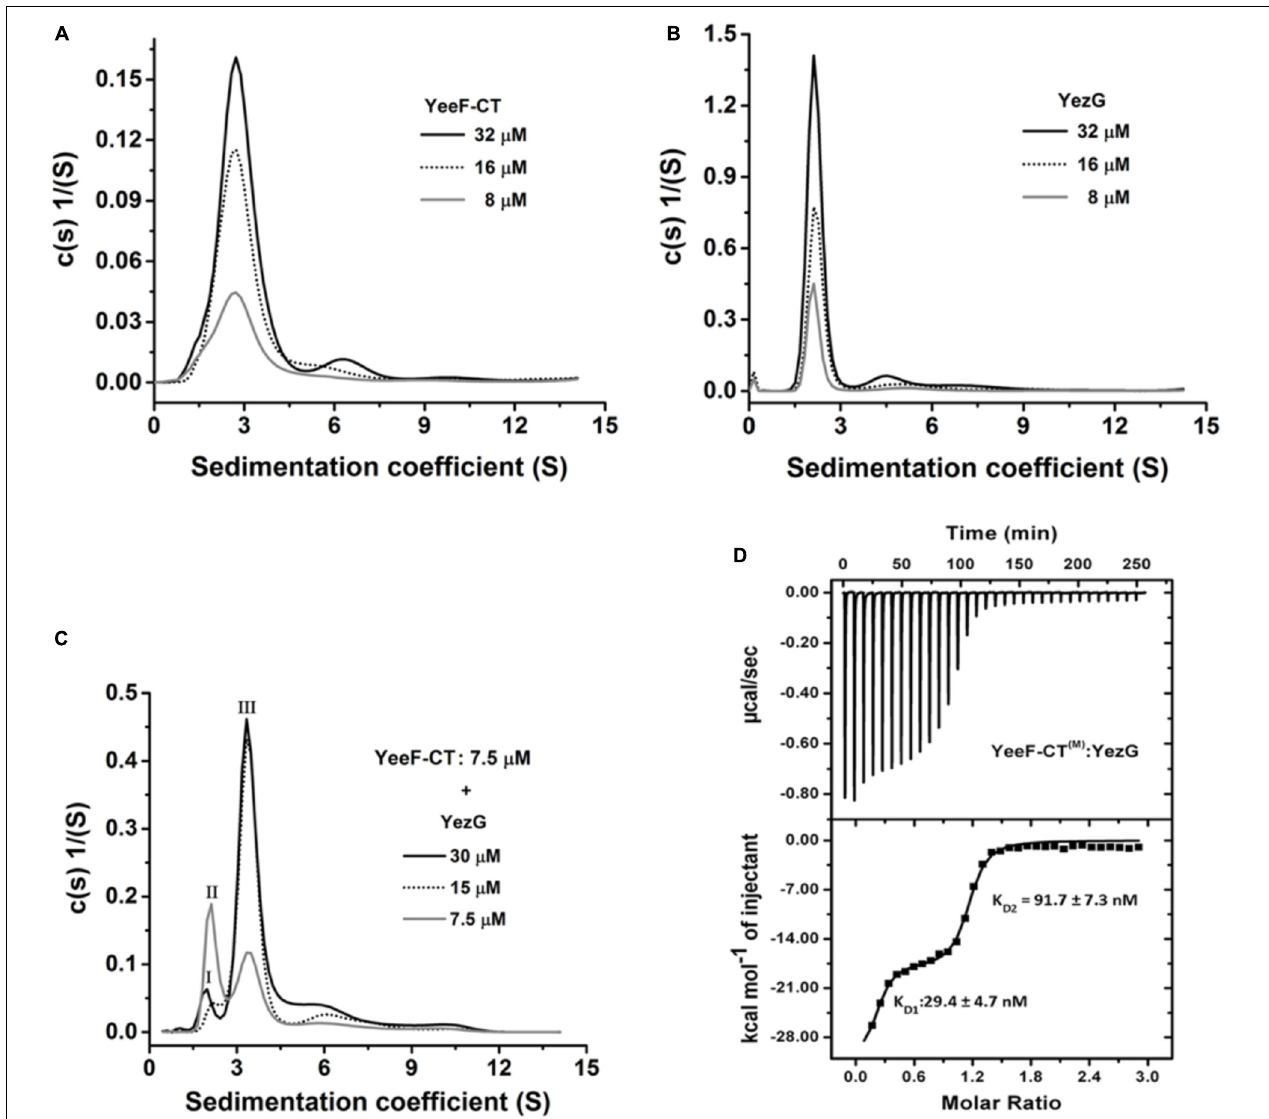
FIGURE 4 | Oligomeric state and binding kinetics of YeeF-CT, YezG, and their interactions. Sedimentation coefficient distribution (s) of YeeF-CT, YezG, and YeeF- CT/YezG are shown in panels A–C , respectively. (A,B) YeeF-CT and YezG exist predominantly as a homodimer and monomer in solution, respectively. (C) YeeF-CT/YezG associate to form a heterotetramer in solution. Peak I and II correspond to excess YezG and YeeF-CT, respectively. Peak III corresponds to YeeF-CT/YezG complex. In all the protein samples, a minor concentration-dependent higher order oligomer population is also observed. (D) A representative isotherm profile of YeeF-CT and YezG interactions. The upper panel represents the calorimetric titration and the lower panel represents derived binding isotherm plotted versus the molar ratio of the